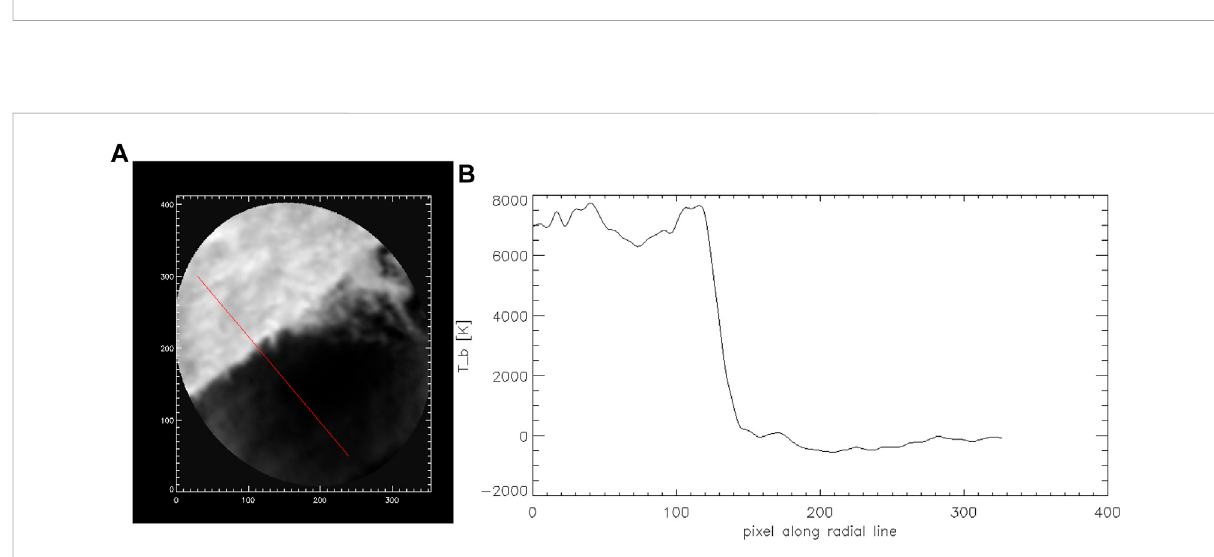
FIGURE 4 (A) : Prominence analysed in Section 7.2 with red-marked radial line. (B) : A pro fi le of the brightness temperature along the radial line in the (A) . Theparameters infeather() hasbeenselectedsuchawaythatthecoronalbrightnesstemperatureisclosetozeroandthebrightnessofthesolardisk corresponds to that observed by the TP